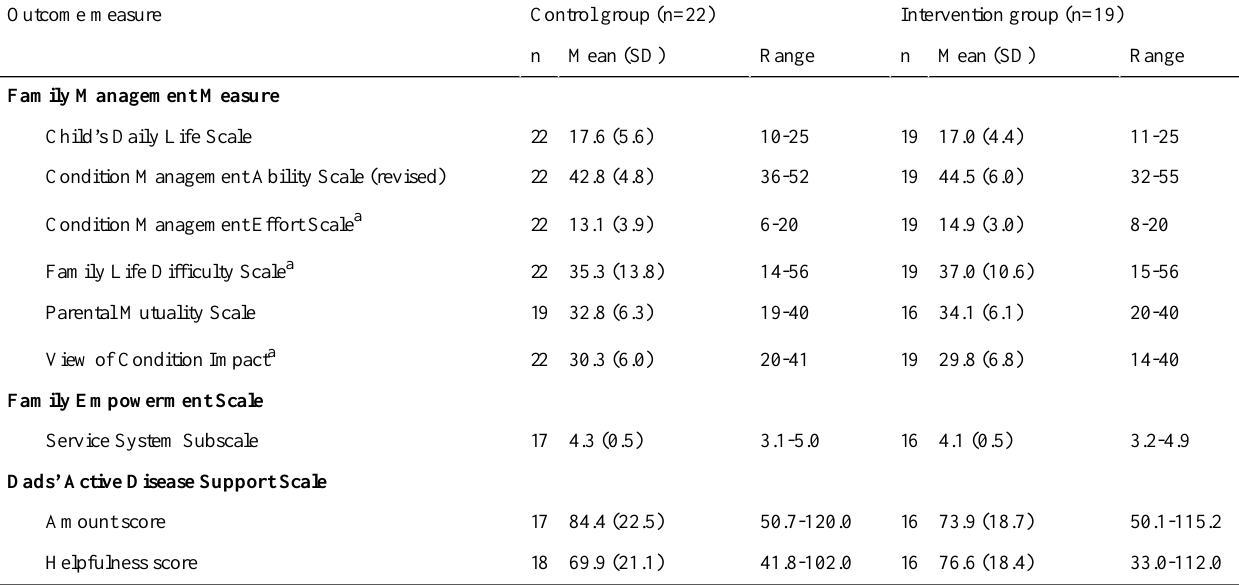
Table 4. Outcome scores at baseline by randomized group for parents completing the